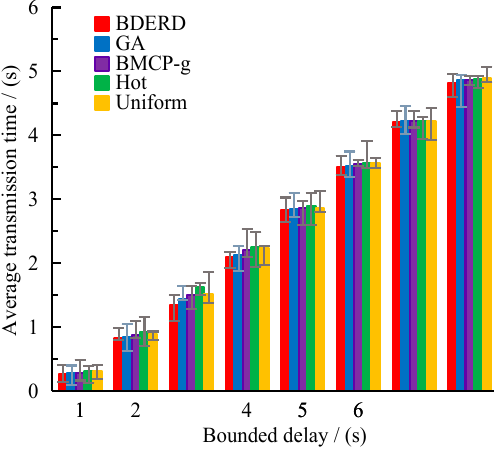
Figure 5. Average transmission time versus the bounded delay.